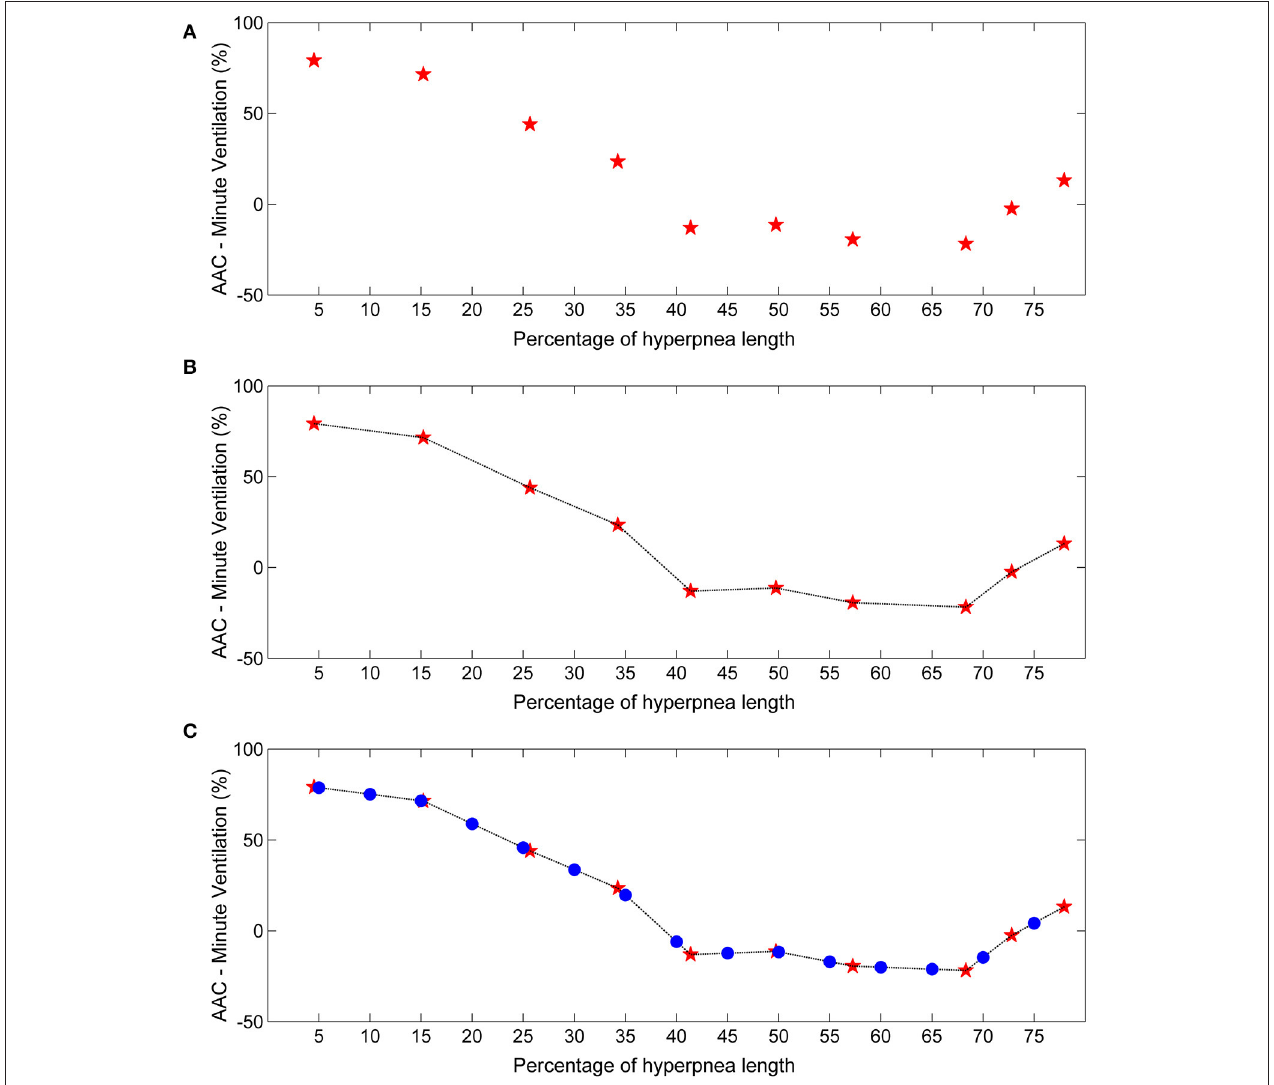
FIGURE 2 | Example of estimation of the time course of the arousal-associated change (AAC) in minute ventilation. (A) Raw time course of the AAC. Red stars represent AAC estimates for each consecutive breath of the hyperpnea (first, second etc.) as a function of percentage of hyperpnea length. Percentages are reported up to 75% of hyperpnea length due to missing data in almost all patients (see details in the Results section). (B) Linear interpolation of AAC estimates. (C) The AAC was re-computed (blue dots) at predefined percentages of hyperpnea length (5, 10, 15%, ….) in order to compare the time course of the AAC among